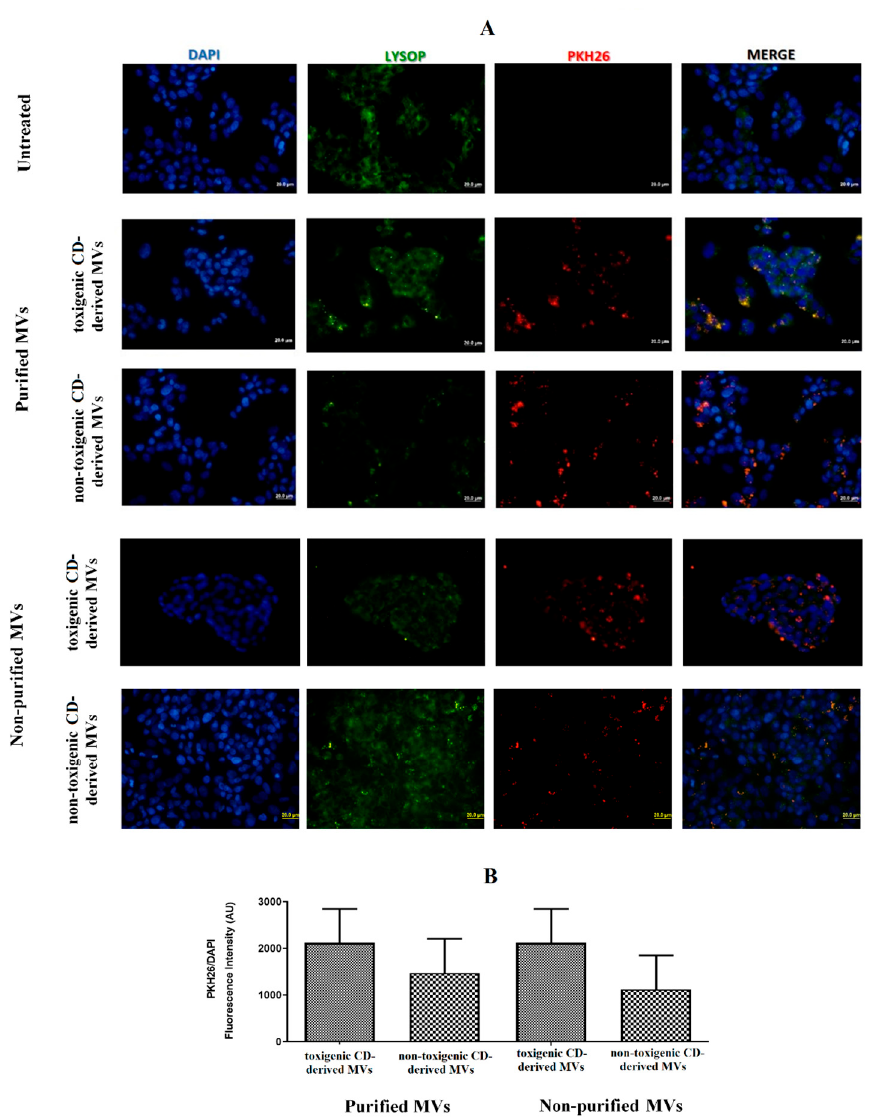
Figure 3. MVs from C. difficile (CD) are taken up by HepG2 cells. ( A ) HepG2 cells were incubated with PKH26-labeled MVs (30 µ g total protein/mL) for 24 h. MVs from non-toxigenic and toxigenic C. difficile strains, both non-purified and purified by SEC, were used. After incubation, nuclear DNA was stained with DAPI, and lysosomes were stained with Lysosomal Staining Kit-Green Fluorescence-Cytopainter. Cells were visualized with an Olympus BX51 (20x). ( B ) PKH26/DAPI ratio fluorescence intensity at the different conditions used in the incubations with C. difficile -derived MVs. Data represent mean ± SEM ( n = 3).